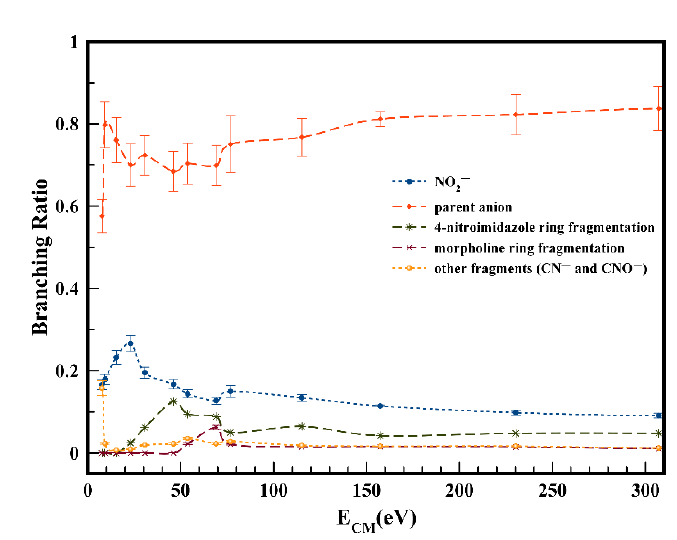
Figure 3. NIMO branching ratios (fragment anion yield/total anion yield) of the main anions formed as a function of the collision energy in the center-of-mass frame. Error bars are related to the experimental uncertainty associated with the ion yields. The lines were added just to guide the eye. See text for details.